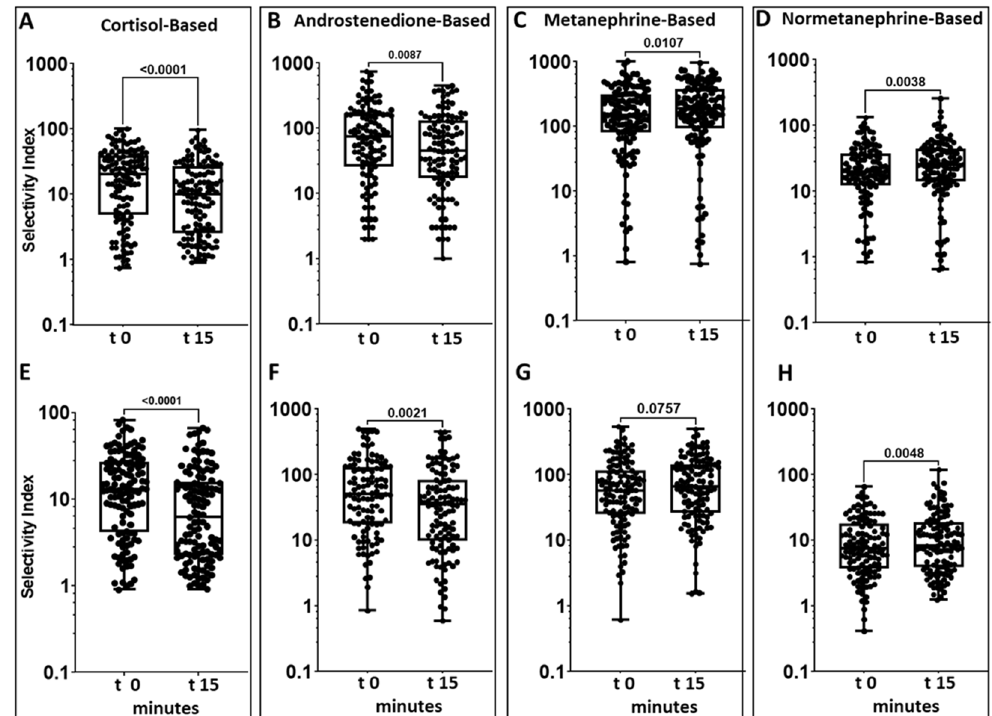
Figure 5. The box and whiskers plots show that on both the right (Panels A and B ) and the left side (Panels E and F ) the SI values for cortisol and androstenedione were higher when starting catheterization (t-15) than 15 min afterwards (t0). The SI for metanephrine and normetanephrine showed and opposite trend (Panels C and D for right side, Panel G and H for left side), likely because of the constitutive adrenomedullary release of these biomarkers.